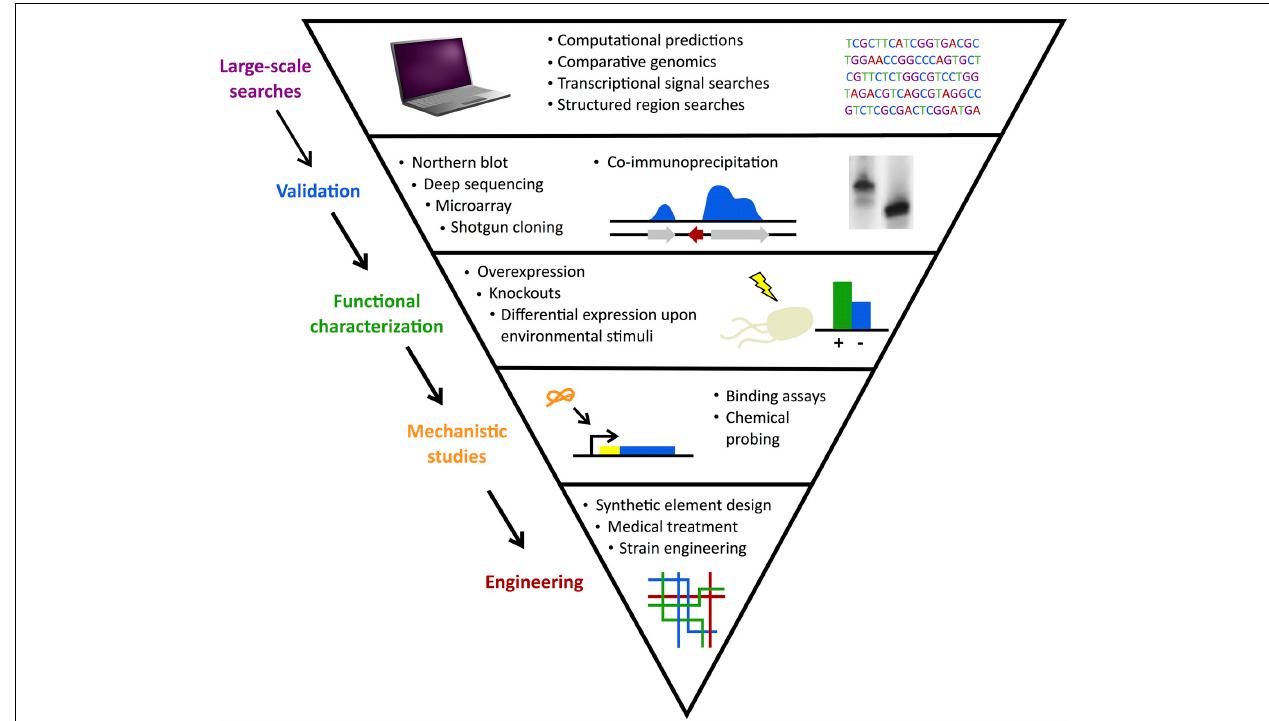
FIGURE 2 | sRNA search and characterization. Discovery of sRNAs often begins with large-scale computational searches followed by experimental validation. Functional characterization of confirmed candidates identifies their